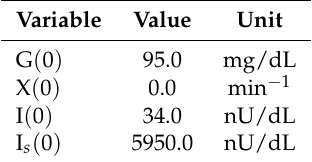
Table 10. Initial condition determined for the control group and groups Cd1 and Cd2 at PND60.